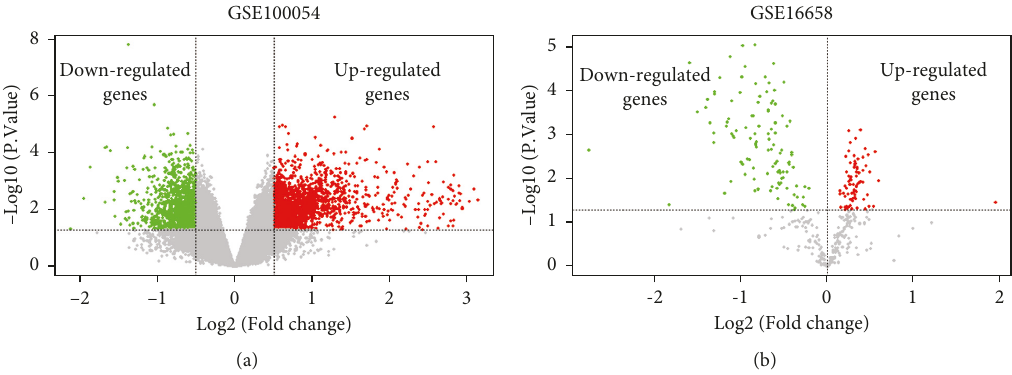
Figure 1: Identification of DEGs and DEmis between PD patients and healthy controls. (a) Volcano plots of 1505 upregulated DEGs and 1302 downregulated DEGs in PD patients (a) and 77 upregulated DEmis and 112 downregulated DEmis were identified in PD patients (b) compared with the control groups. p 0 . 05 is taken as a threshold. Blue dots represent upregulated genes or miRNAs, red dots indicate upregulated ones, and grey dots represent no significance. The abscissa axis represents log2 |fold change|, and the vertical axis represents log10 |( p ) value|. < −